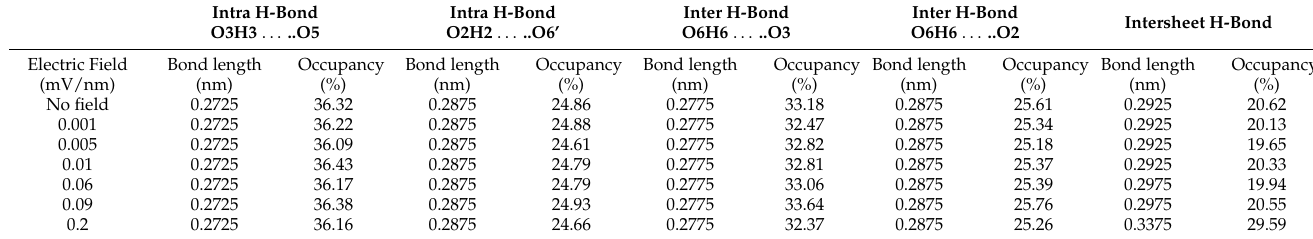
Table 2. The hydrogen bond formation distance between the donor and acceptor atoms of cellulose and their occupancy under an external electric field (electric field along the